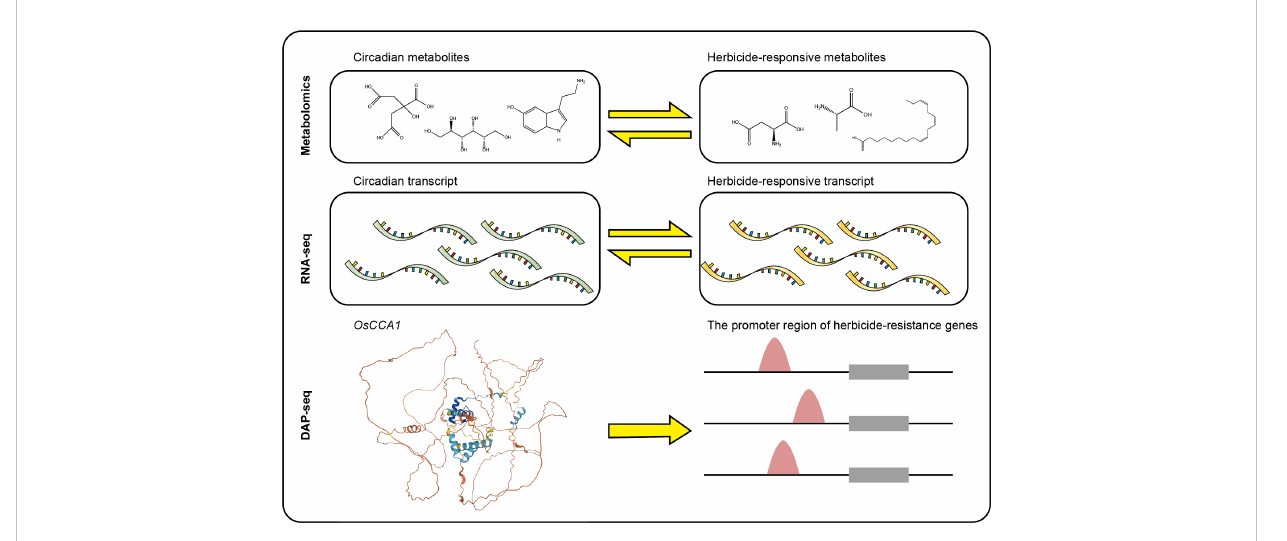
FIGURE 1 Schematic overview of the work fl ow and analysis pipeline in this